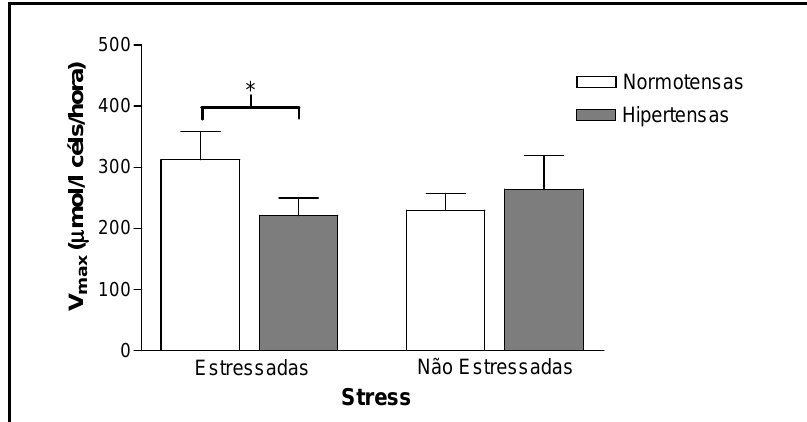
Figura 1 . Transporte celular de L-arginina em eritrócitos pelo sistema y + em hipertensas e normotensas de acordo com o stress. Nota . * p <0.05.